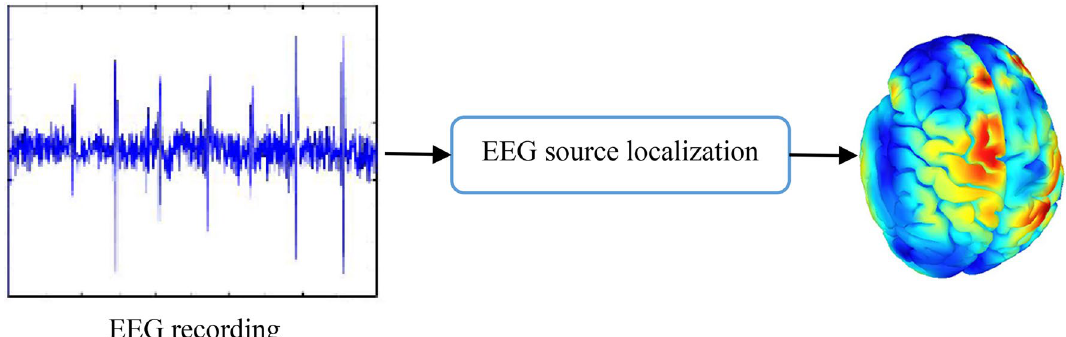
Figure 1. Source localization procedure of emotional EEG signal (using drawing canvas of Microsoft office word 2016 https:// www. micro soft. com/ en- us/ downl oad/ detai ls. aspx? id= 51791 and Brainstorm version 3.211110 https:// neuro image. usc. edu/ bst/ downl oad.